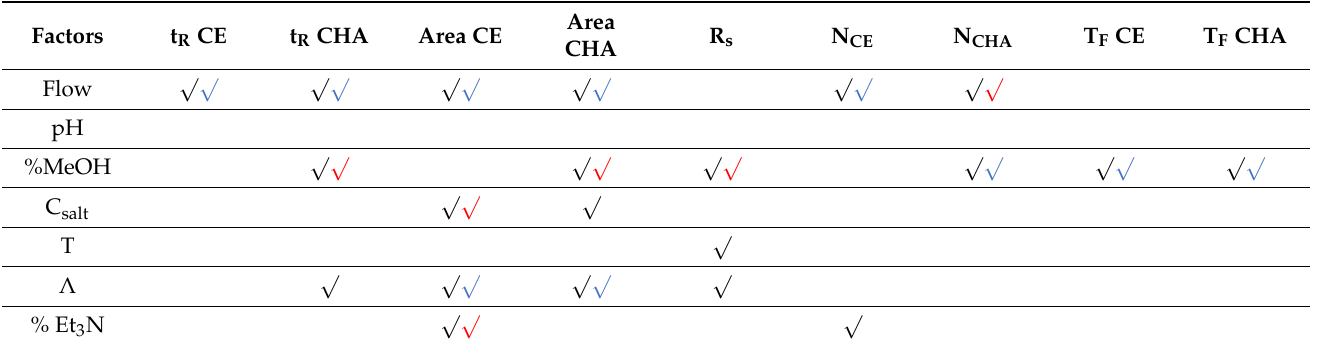
√ ) and graphical approach ( √ ).